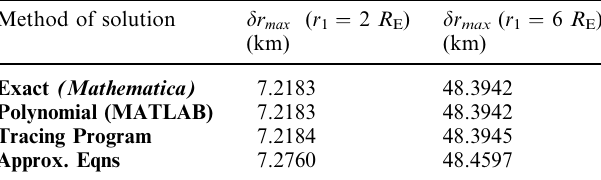
Table 3. Comparison between various numerical estimates for (cid:100) r max at the geomagnetic equator in the special axisymmetric case